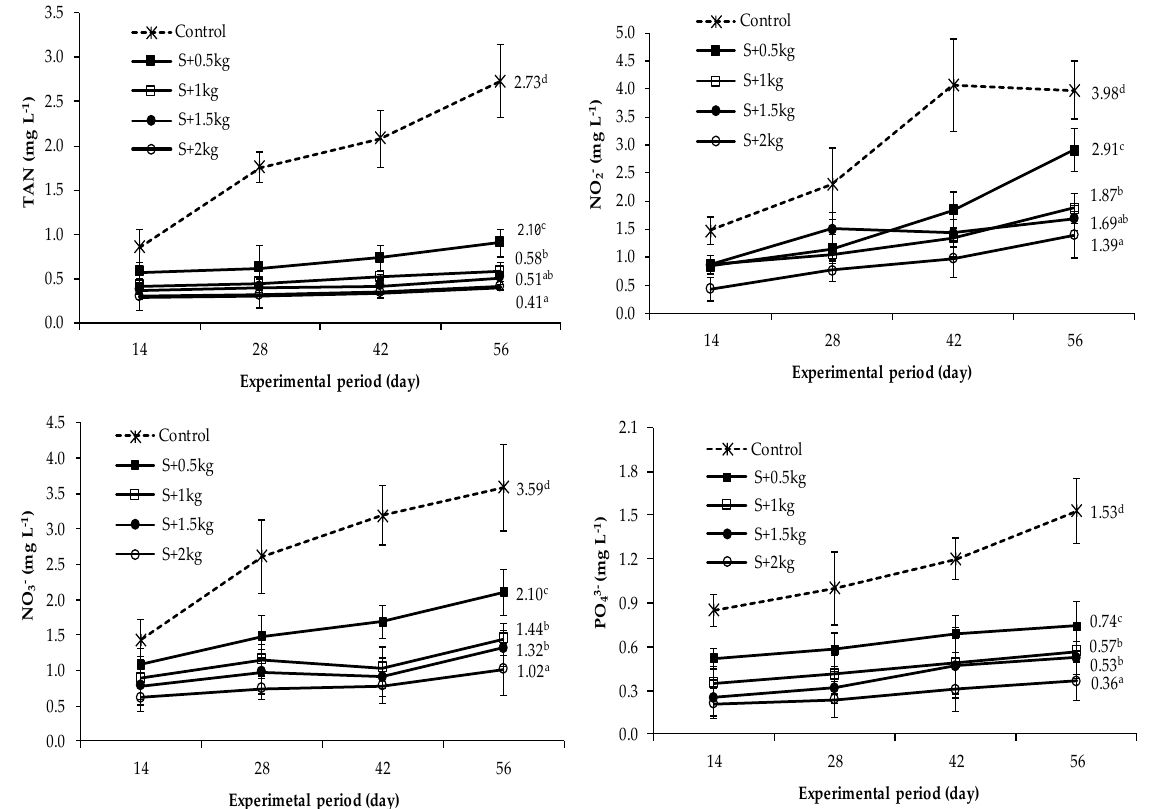
Table 3. The growth rate of sea grape integrated with whiteleg shrimp after 56 days of culture. Figure 3. Variation in concentrations of total ammonia nitrogen (TAN), nitrite (NO 2 − ), nitrate (NO 3 − ), and phosphate (PO 43 − ) during the culture period. Different superscripts indicate significant differences ( p < 0.05) among treatments. The error bars stand for the mean values and standard deviation. The different superscripts a, b, c, d illustrates the statistical difference in water quality parameters among the treatments.